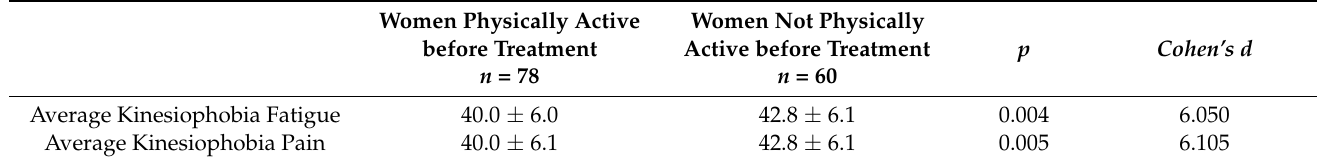
Table 3. The impact of lifestyle before BC diagnosis on the level of kinesiophobia one year